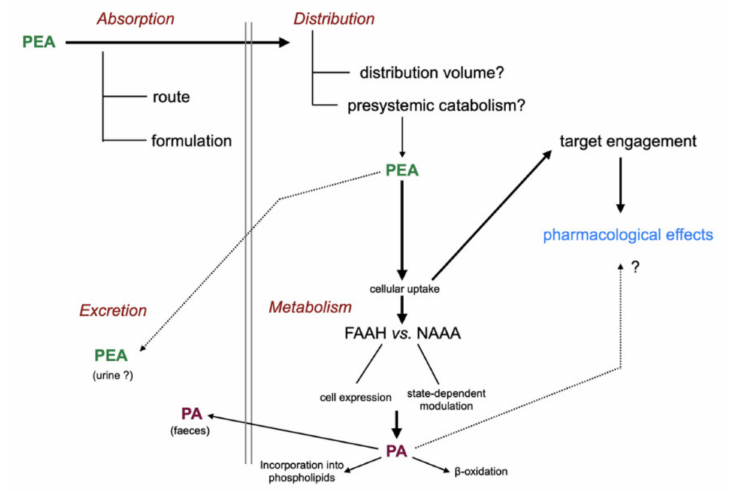
Figure 3. Absorption, distribution, metabolism, and excretion of PEA. Abbreviations: FAAH, fatty acid amide hydrolase; NAAA, N -acylethanolamine acid amidase; PA, palmitic acid. For details with respect to the metabolism of PA, see